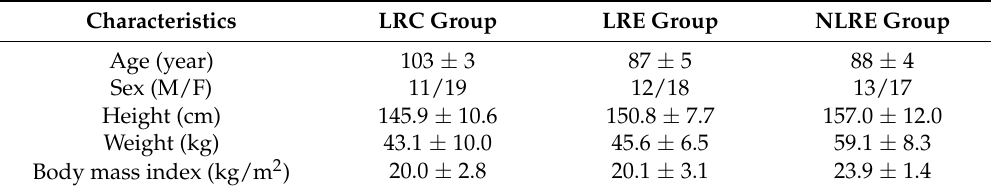
Table 1. Participant characteristics 1